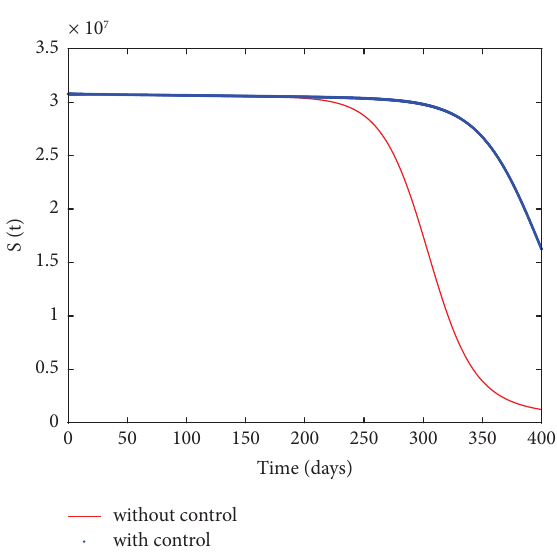
Figure 9: Behaviour of the susceptible individuals with and without the control.